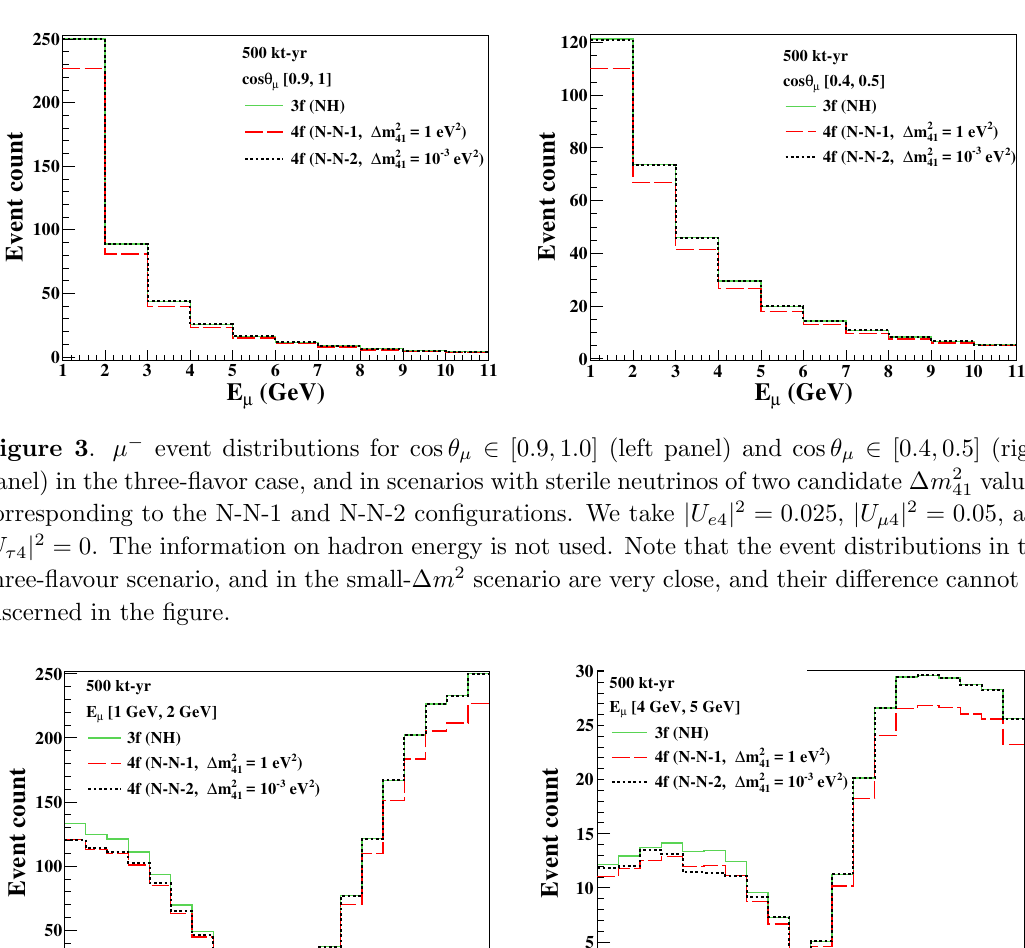
values, 41 = 41 in two sample (cid:22) range. On the other hand, (cid:22) = 10 (cid:0) 5 eV 2 41